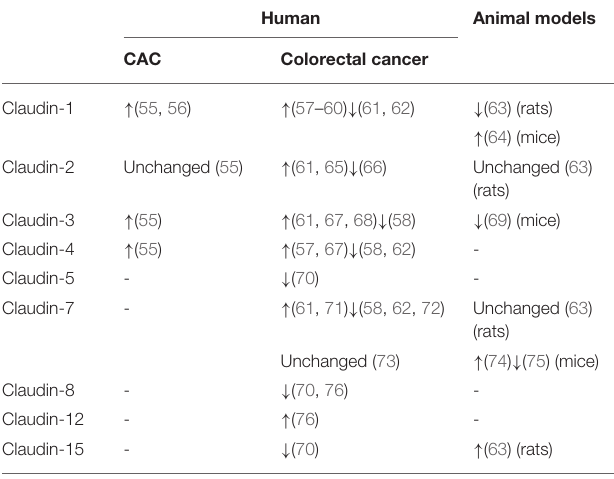
TABLE 1 | Changes of claudins in colitis-associated colorectal cancer (CAC) and colorectal cancer. Human Animal